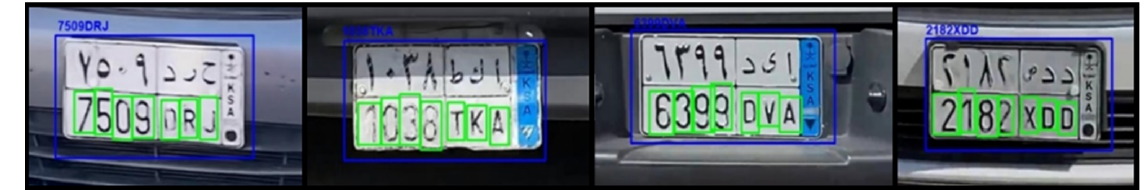
Figure 16. Partially deteriorated alphanumeric and respective recognition results.